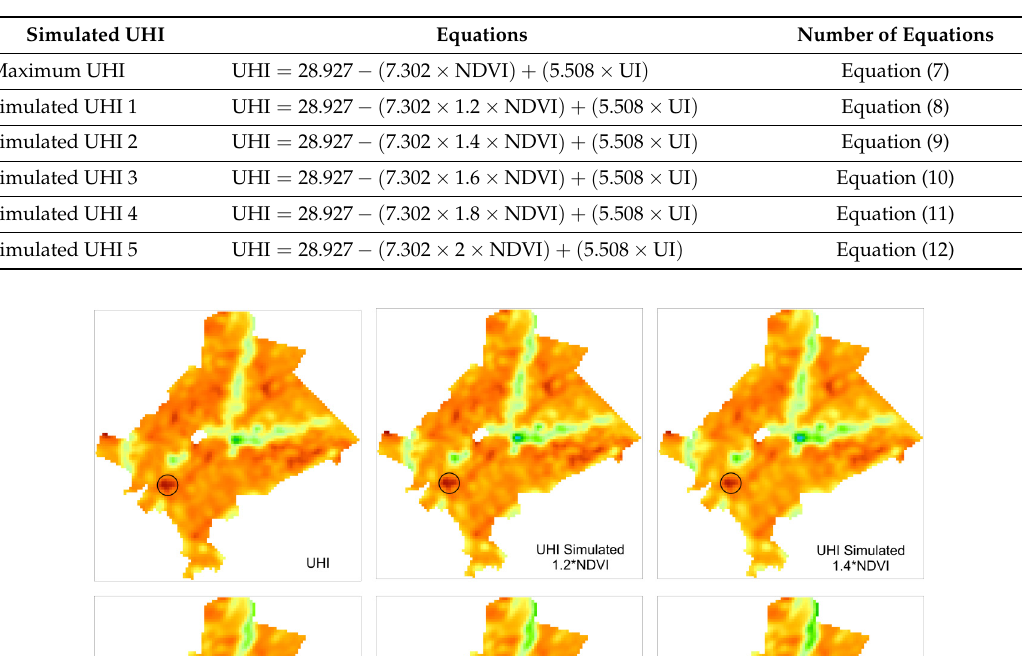
Table 3. Equations used to simulate the maximum UHI with increases in NDVI.